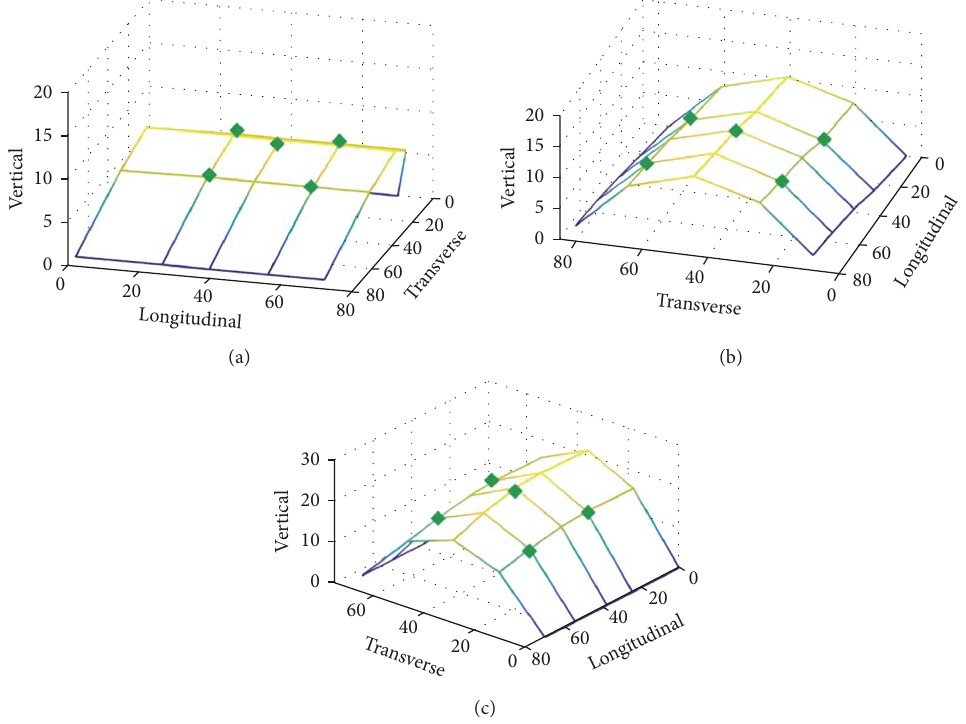
Figure 35: Mode shapes identified using NExT+ERA from 12:00:00, 13 Sep. 2017 to 12:30:00, 13 Sep., 2017: (a) the 1st mode shape (longitudinal); (b) the 2nd mode shape (transverse); and (c) the 4th mode shape